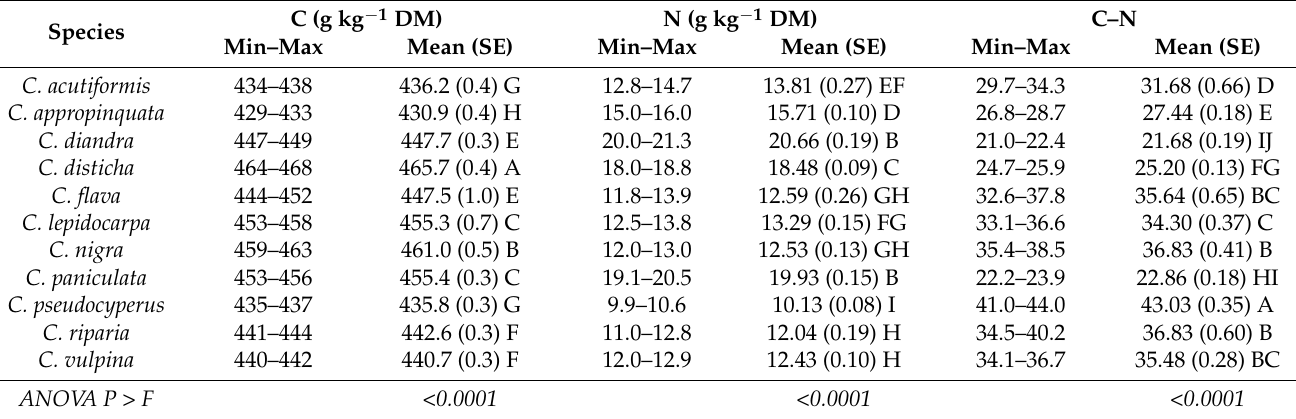
Table 4. Ranges (min–max) and mean values ( ± SE) of carbon and nitrogen content and C–N in aboveground biomass of the Carex taxa. One way analysis of variance (ANOVA) were performed separately for C, N, and C–N. The same letters indicate a lack of statistically significant differences among species analysed according to Tukey’s a posteriori test ( p <